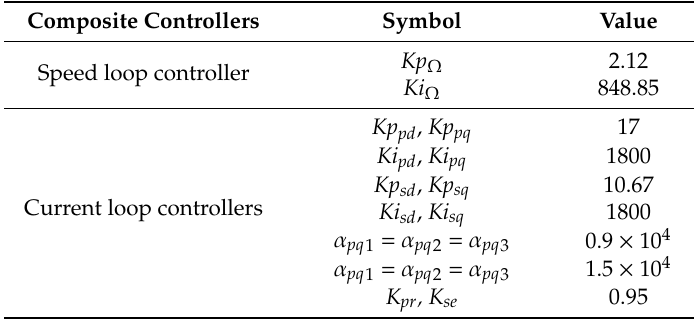
Table A2. Parameters of fault-tolerant composite controllers in the experimental